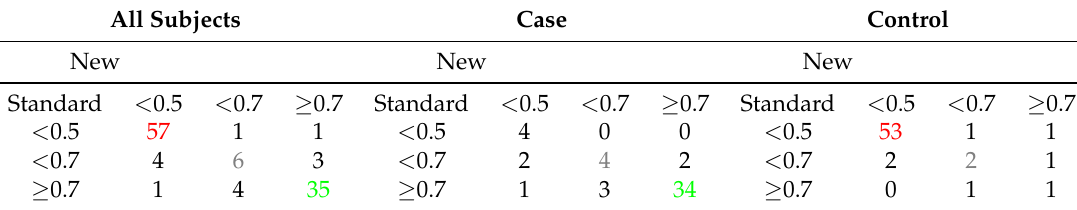
Table 3. Reclassification table obtained for model 2 using NRI, 0.5 and 0.7 values represent the cutoff range used to calculate the risk category. Values in red represent true negatives, values in green represent true positives, and values in the cutoff range are presented in gray. False positives and false negatives are presented in